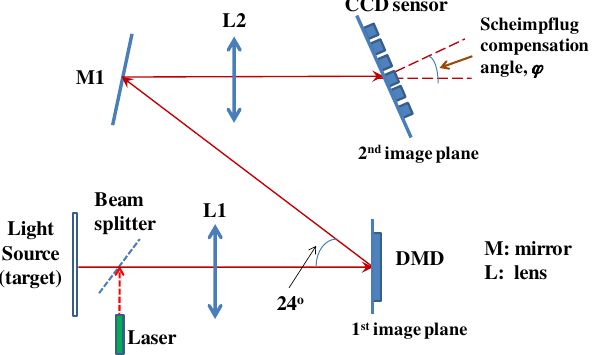
FIG. 1. Schematic of halo imaging optics using